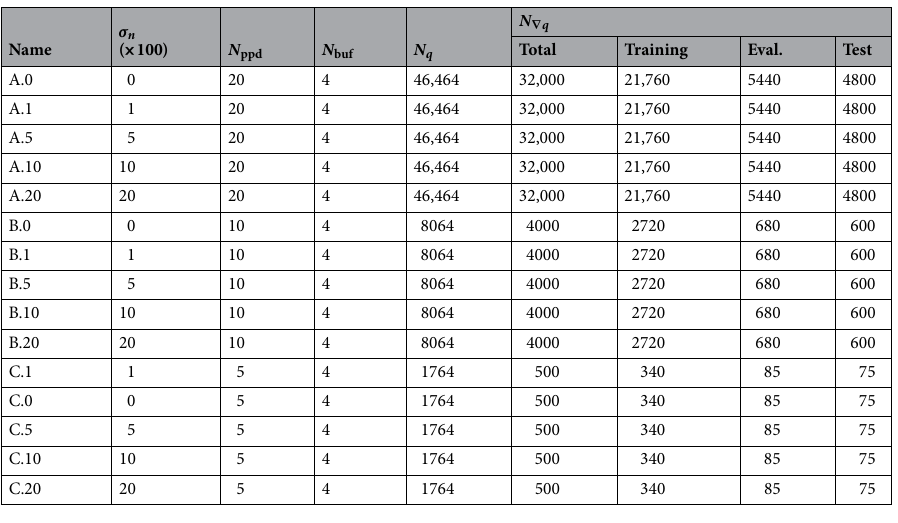
Table 2. Datasets: the columns represent the datasets’ name, the percentage of random relative noise added to the flux function, the sampling density represented by the points-per-decade parameter, the total number of buffer grid points, and the total number of flux function evaluations. The last four columns relate to the gradient function datasets (three components each), including the total number of evaluations and its partitions into training (68%), evaluation (17%) and test (15%) sets, respectively.